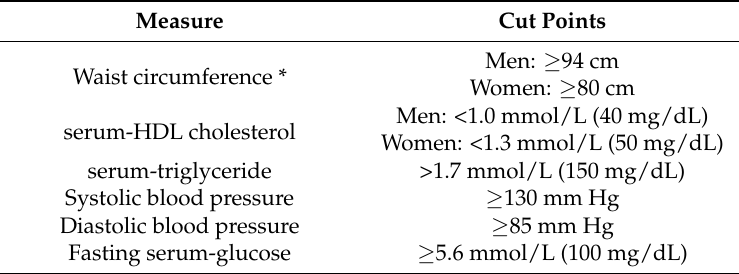
Table 1. Criteria for diagnosing the metabolic syndrome (MetS)